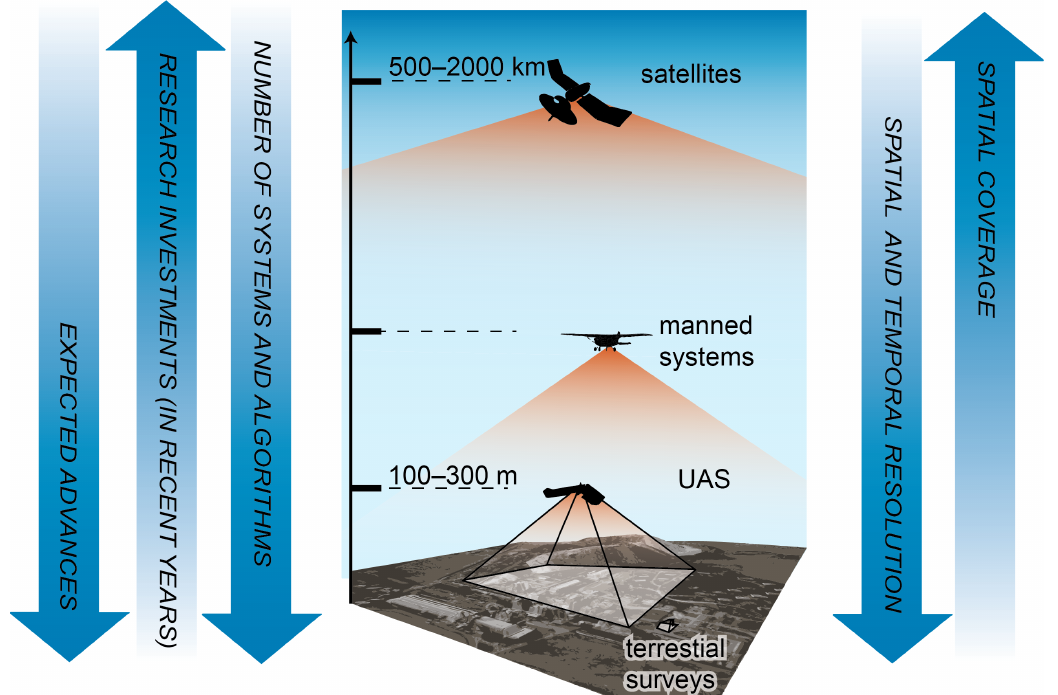
Figure 1. Comparison of the most important aspects of spatial data acquisition, after